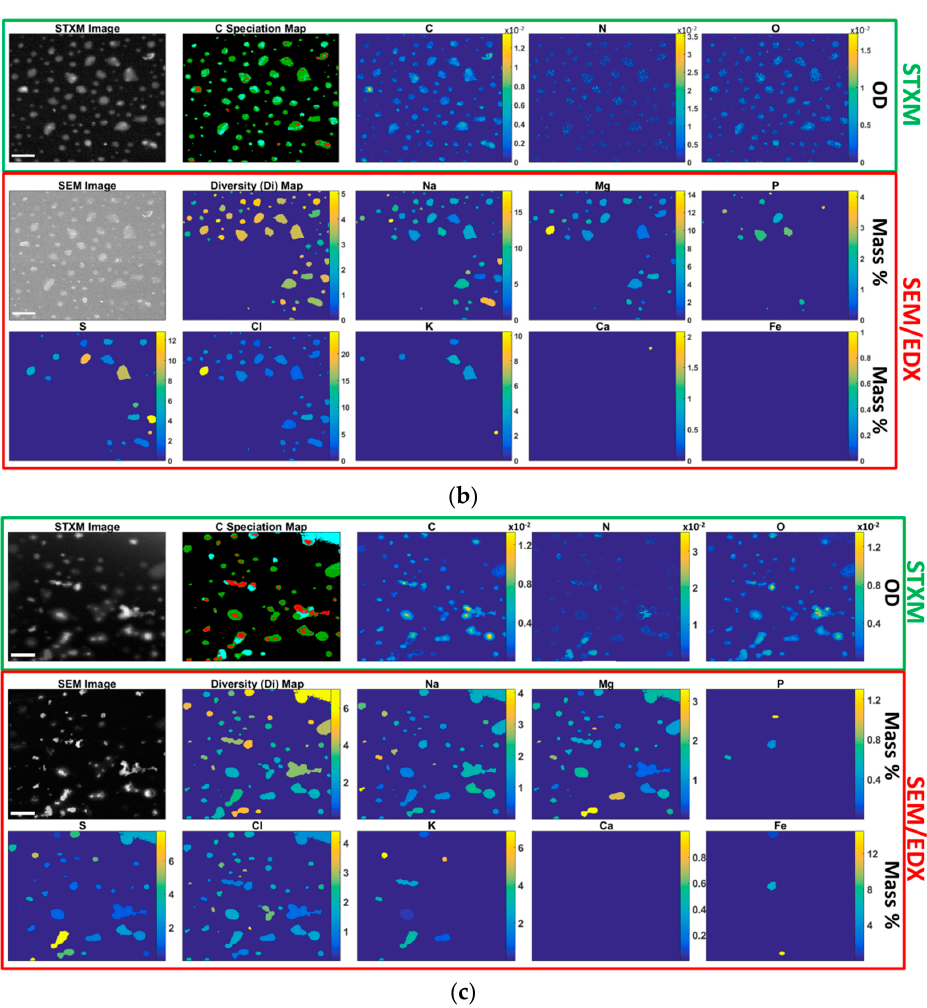
Figure 2. Raw and processed image maps for selected Field of Views (FOVs) from ( a ) the Amazon Tall Tower Observatory (ATTO) site collected on 15 October 2014, ( b ) the ZF2 site collected on 3–6 October 2014, and ( c ) the T3 site collected on 13 September 2014. Raw images for Scanning Transmission X-ray Microscopy (STXM) and Scanning Electron Microscopy (SEM) are shown (with 2 µm scale bar in bottom left) along with false color maps showing the sub-particle (for C, N, and O) or per-particle (for higher Z elements) mass distribution. Also shown is a color coded carbon speciation map showing soot (red), inorganic (teal), and organic (green) carbon. The calculated individual particle diversity ( D i ) is also shown. Note the large spot in the upper right corner of the T3 sample, this was most likely the edge of the Si 3 N 4 window and was removed from calculations. Also note the empty lower left corner in the ZF2 sample Energy Dispersive X-ray spectroscopy (EDX) data lacking for those particles; because of this they were removed. Zn, Mn, and Ni maps are omitted here as they were not detected in these FOVs.